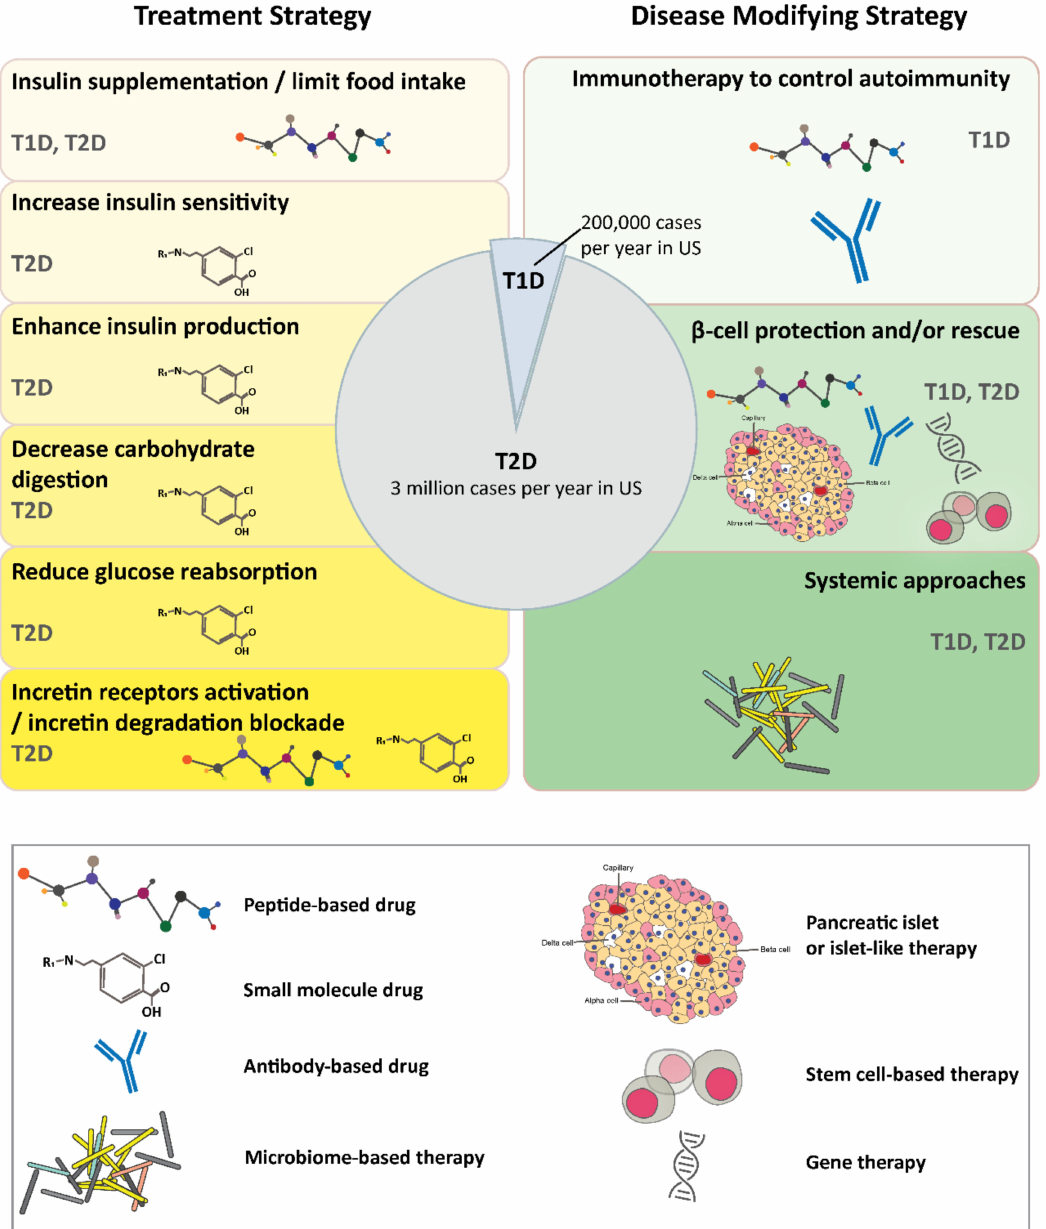
Figure 1. A highlight of therapeutics for T1D and T2D discussed in this review. T1D: Type 1 diabetes; T2D: Type 2